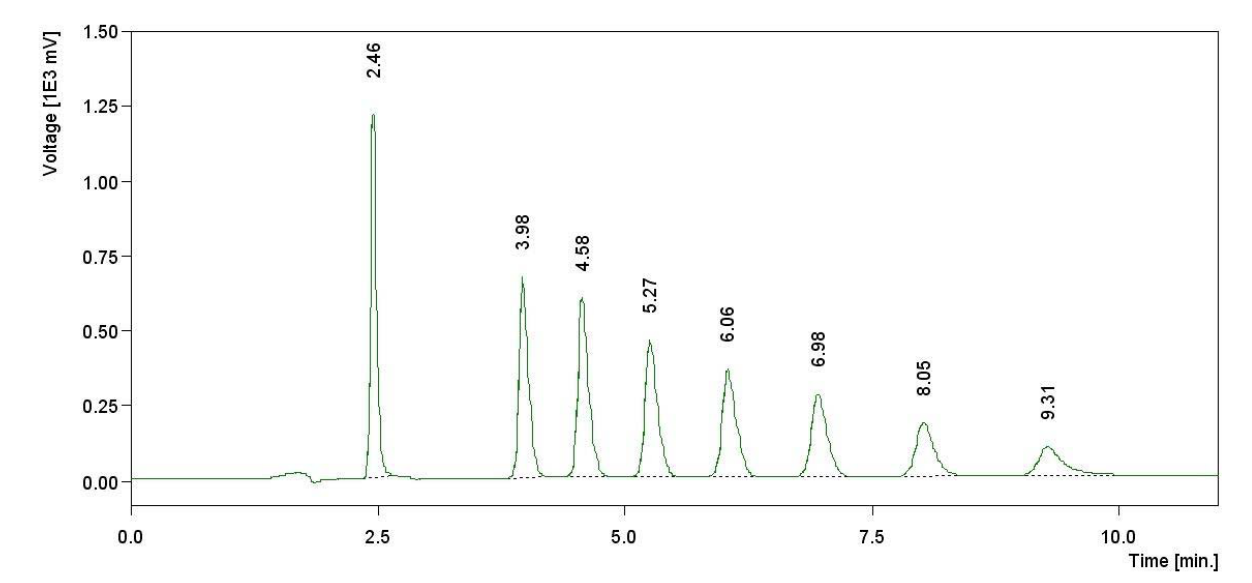
Figure 2. HPLC chromatogram of the prepared pyridinium series